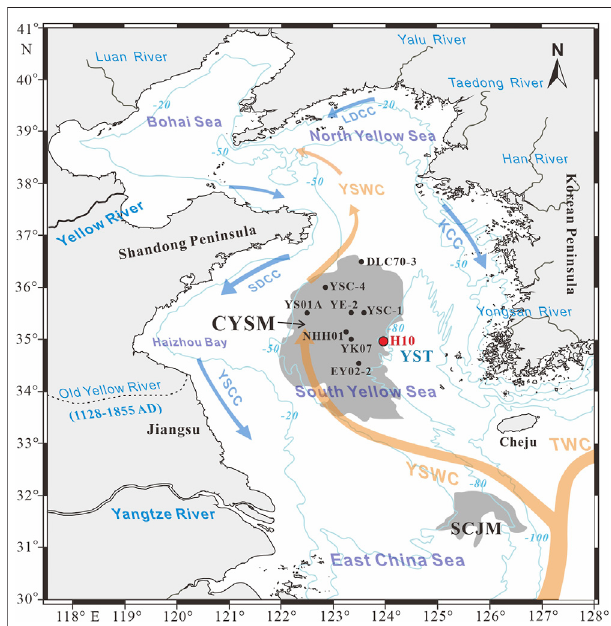
FIGURE 1 | Locations of sediment cores in the central Yellow Sea mud (CYSM) ( Supplementary Table S1 , modi fi ed from Wang et al., 2014b; new core H10 is marked by a red dot) and regional circulation pattern (modi fi ed from Li et al., 2016). The orange lines indicate warm current systems, whereas blue lines indicate cold coastal currents. YSWC, Yellow Sea Warm Current; TWC, Tsushima Warm Current; YSCC, Yellow Sea Coastal Current; KCC, Korean Coastal Current; SDCC, Shandong Coastal Current; LDCC, Liaodong Coastal Current; YST, Yellow Sea Trough; and SCJM, southwest Cheju Island